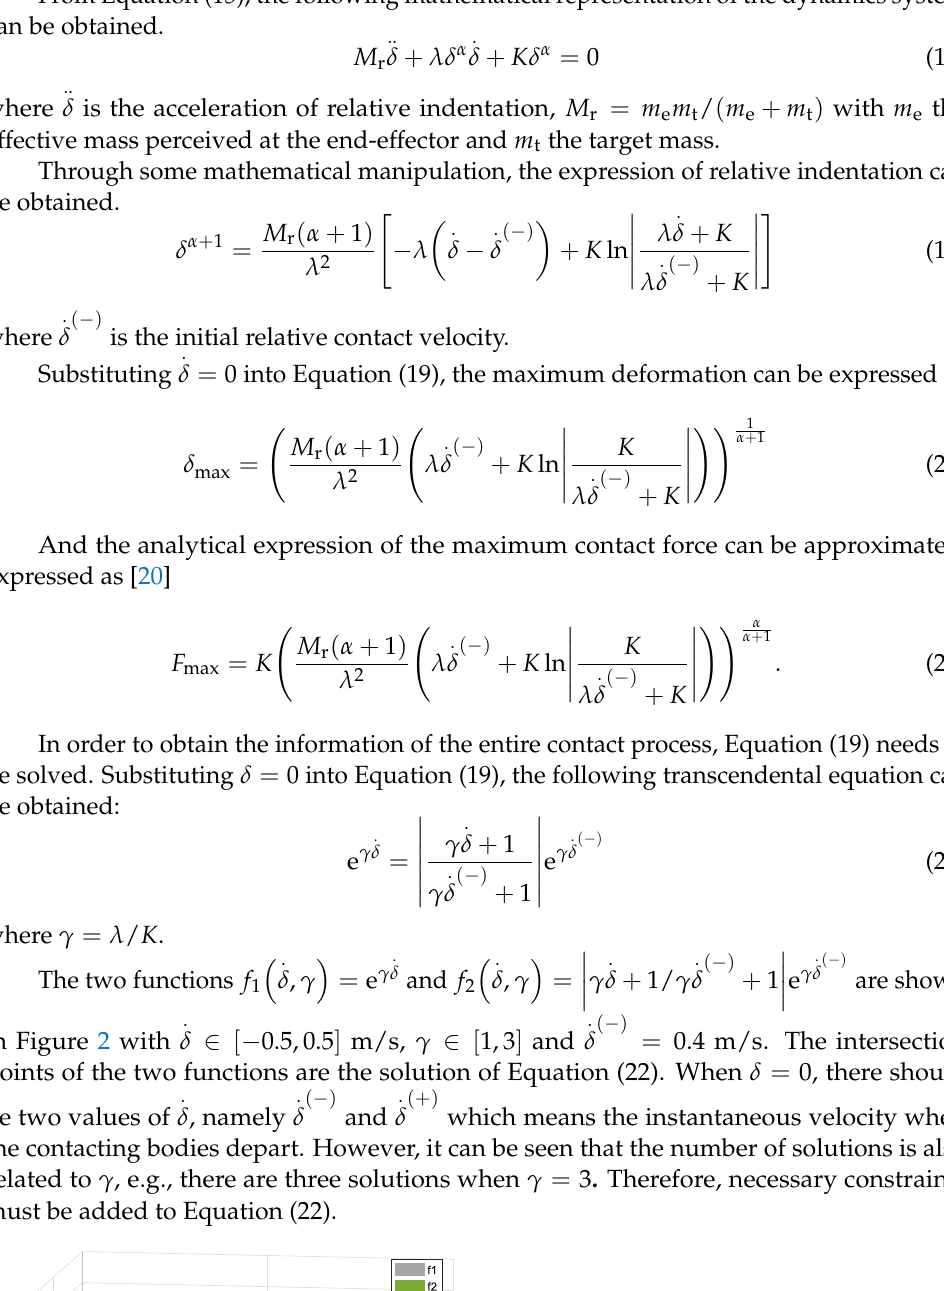
Figure 2. The surfaces of